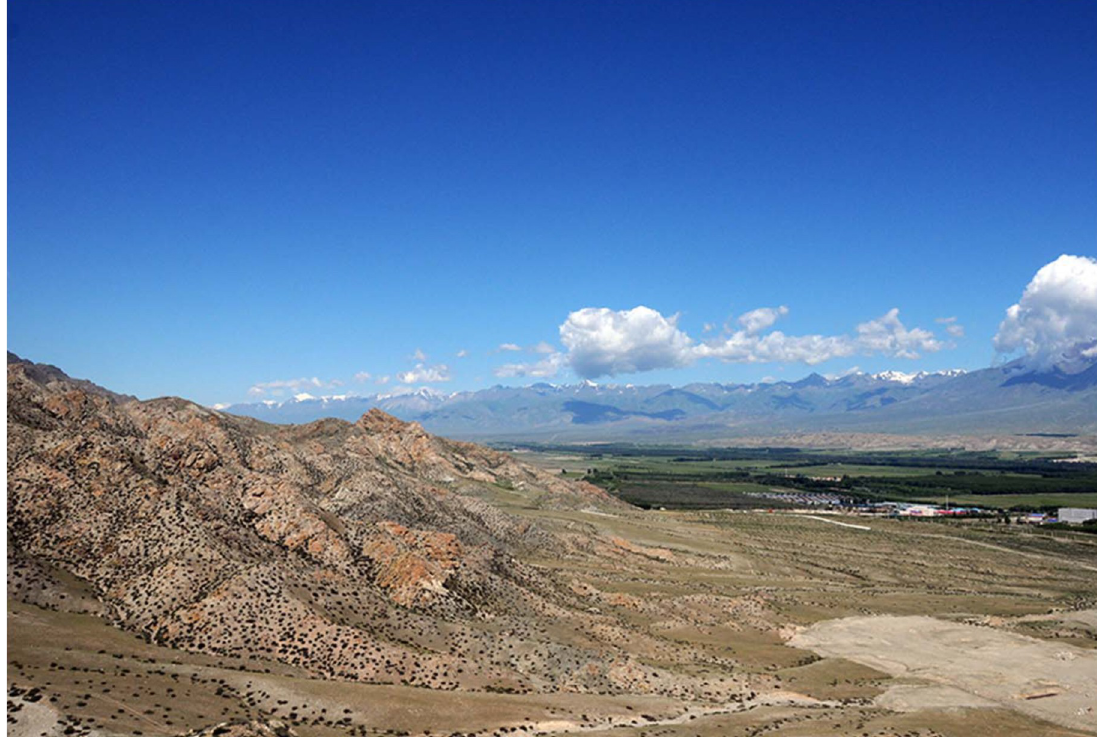
Fig 1. A general view of the Bortala valley looking to the northwest from the town of Wenquan (A.